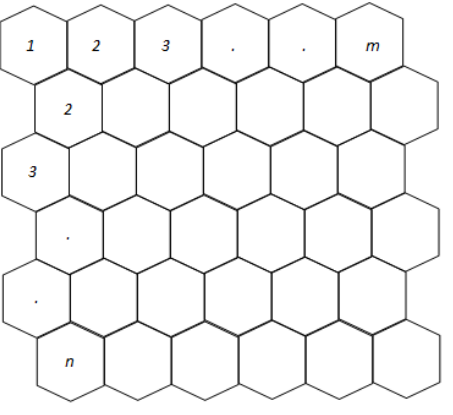
Fig. 2 2 − Dimensional graph of graphene sheet G ( m , n )